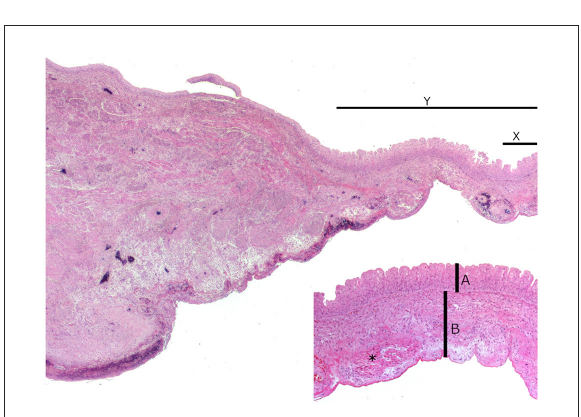
FIGURE2 Microscopic image of the urinary bladder. Normal bladder wall on the left and disintegrating ordinary muscle layer on the right side. This defect is flanked by a juvenile granulation tissue, subserosal bleedings, and individual muscle bundles. Normal bladder wall on the left with detaching ordinary muscle layer on the right side. This defect (Y) is flanked by an immature granulation tissue, subserosal hemorrhage, and individual muscle bundles. Inset (X): local lesion only consists of a transitional cell layer (A) with a thin loosely arranged connective tissue covered with mesothelial cells (B). Individual muscle bundles are present